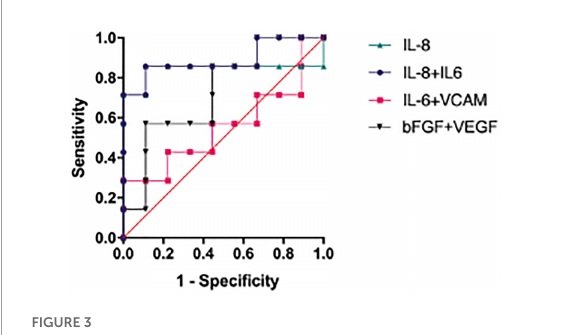
FIGURE3 Accuracy of correlated cytokines in predicting OAG secondary to PSS. IL-8 together with IL-6 ( p = 0.0095) had higher accuracy in predicting OAG secondary to PSS than IL-8 alone ( p = 0.0229). IL-6 with VCAM ( p = 0.7110) and bFGF with VEGF ( p = 0.1248) had no predictive value. bFGF, basic fibroblast growth factor; IL, interleukin; OAG, open angle glaucoma; PSS, Posner-Schlossman syndrome; VCAM, vascular cell adhesion molecule; VEGF, vascular endothelial growth